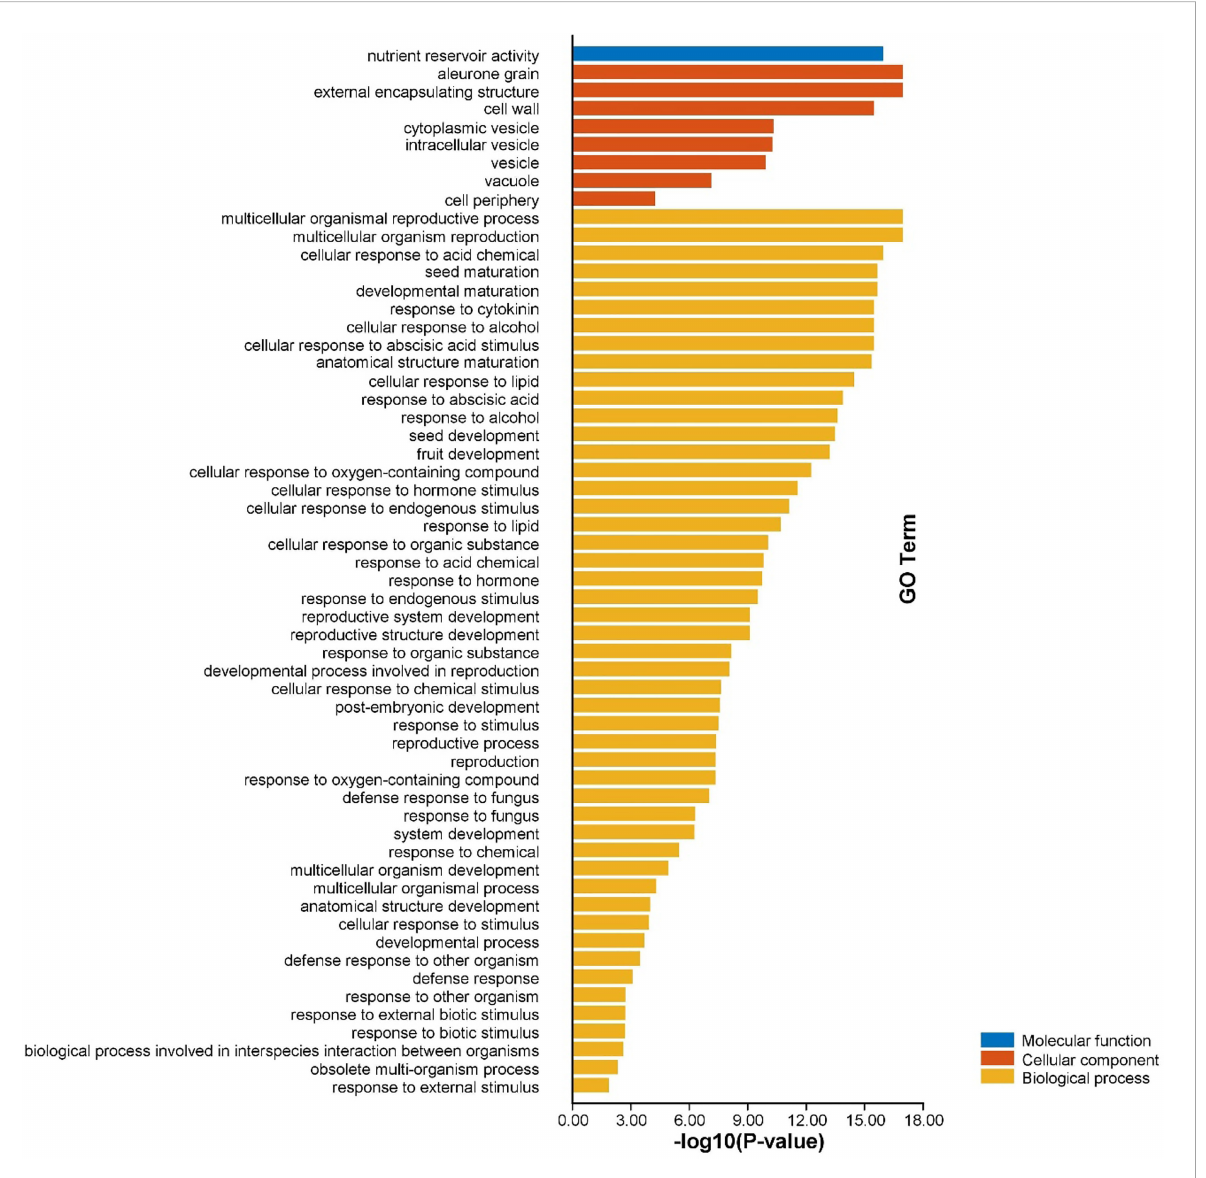
FIGURE 11 Functional annotation (GO) analysis of AhGLPs . The gene ontology enrichment analysis showed that AhGLPs are involved in all categories, including molecular function (MF), cellular component (CC), and biological processes (BP). AhGLPs are involved in a number of important biological processes, including growth and development related, biotic and abiotic stress response, and various stimulus